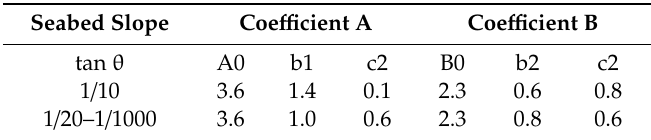
Table 1. Optimum coe ffi cient values of empirical formulas for intercept A and gradient coe ffi cient B (after Goda,